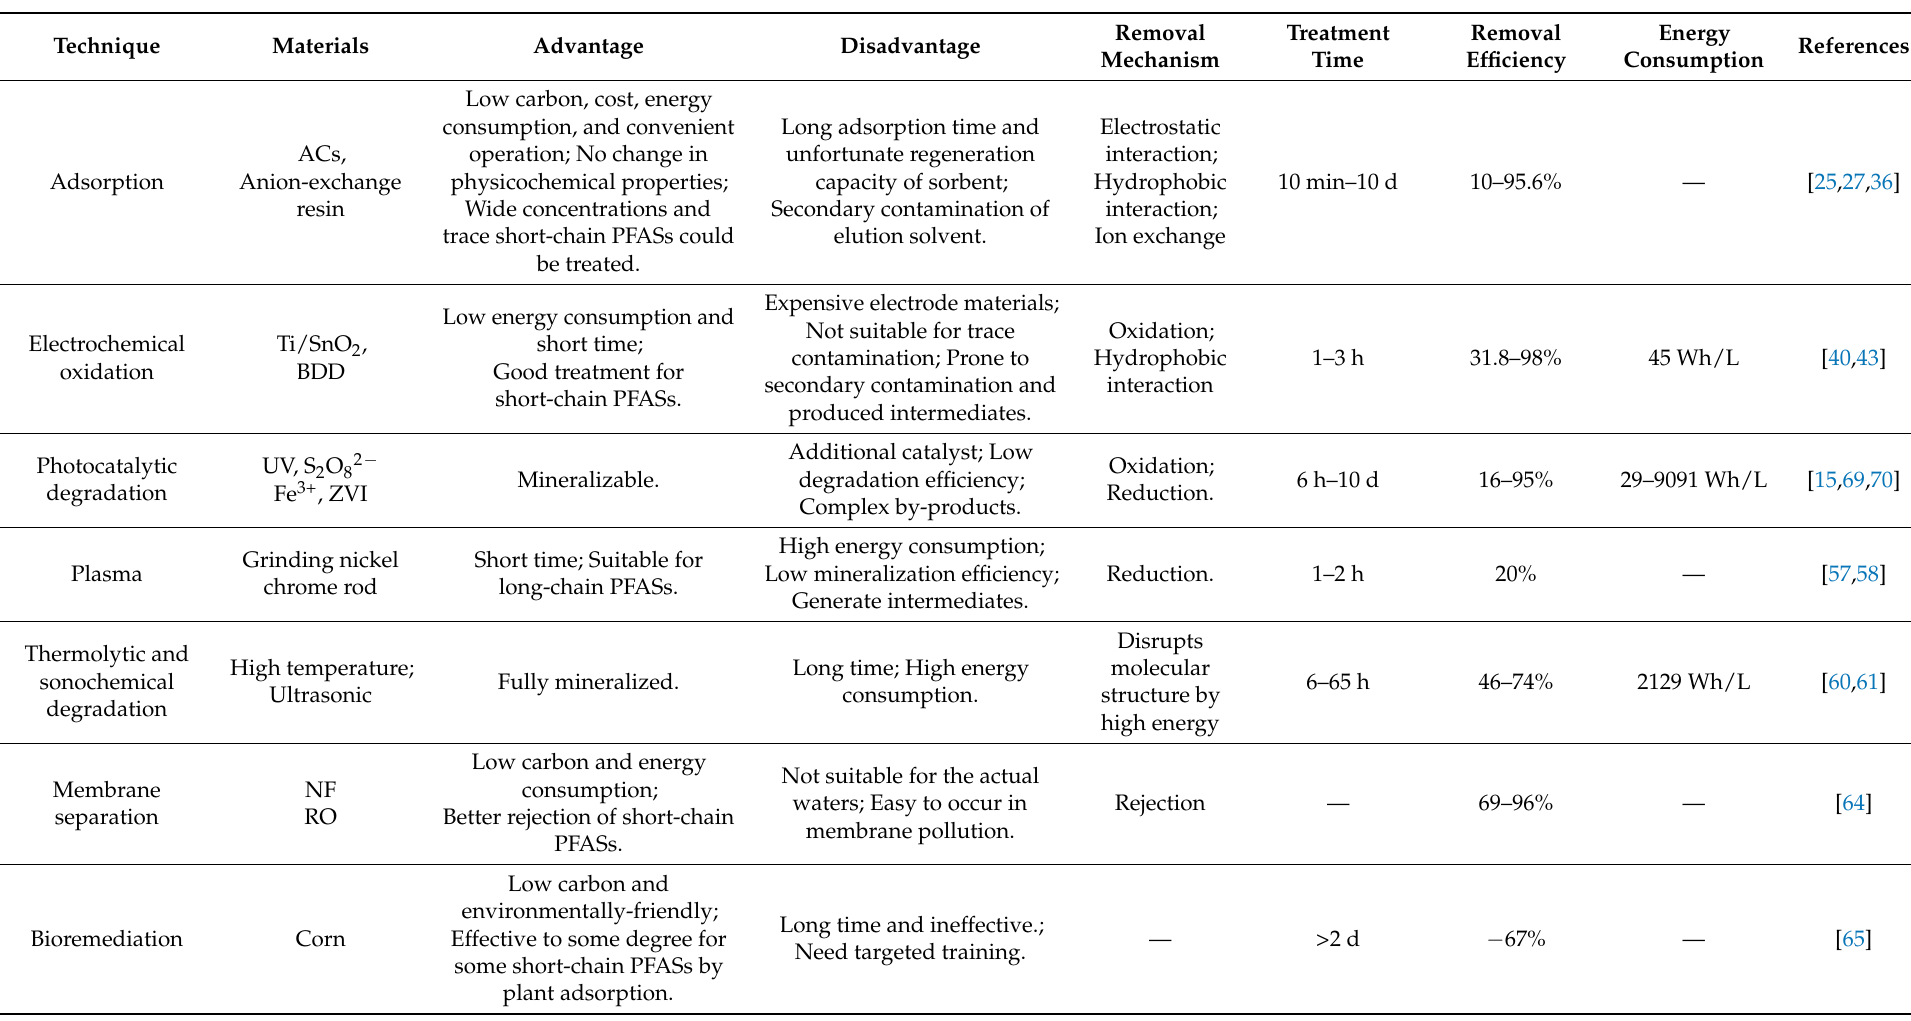
Table 5. Comparisons on treatment techniques for short-chain